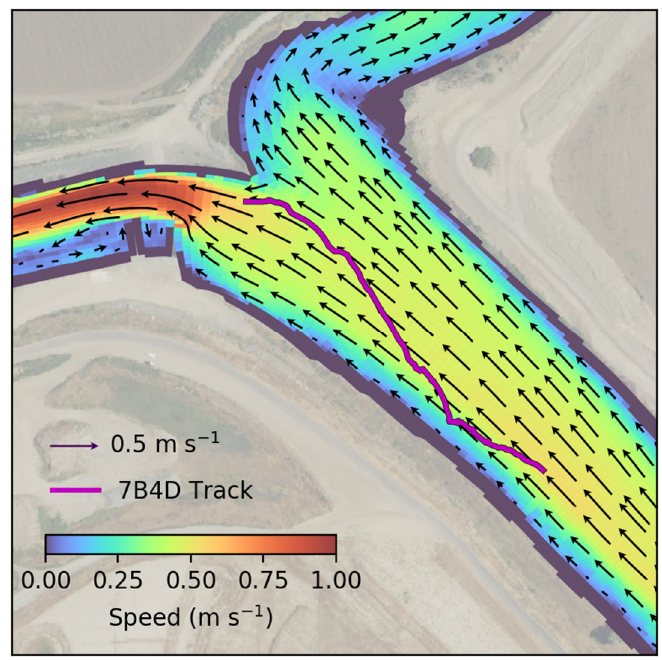
Figure 3. Predicted hydrodynamic speed (colors) and velocity (arrows) fields averaged from the surface to 2 m below the surface on 19 March 2018 at 4:26 a.m., at the time of transit of tag 7B4D. The observed path of tag 7B4D in the acoustic array is shown by the magenta